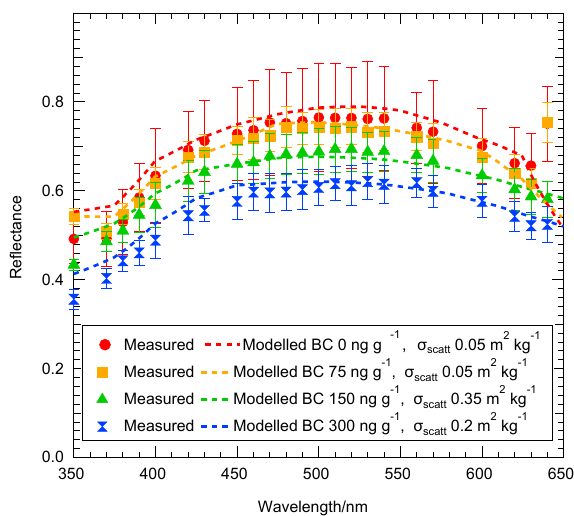
Figure 10. Comparison between measured (solid shapes) and cal- culated (dashed lines) reflectance of laboratory sea ice surface with black carbon in a 5cm surface layer in varying mass ratios. The fig- ure shows the best fit possible by altering scattering cross section of the upper black carbon bearing layer (values shown on